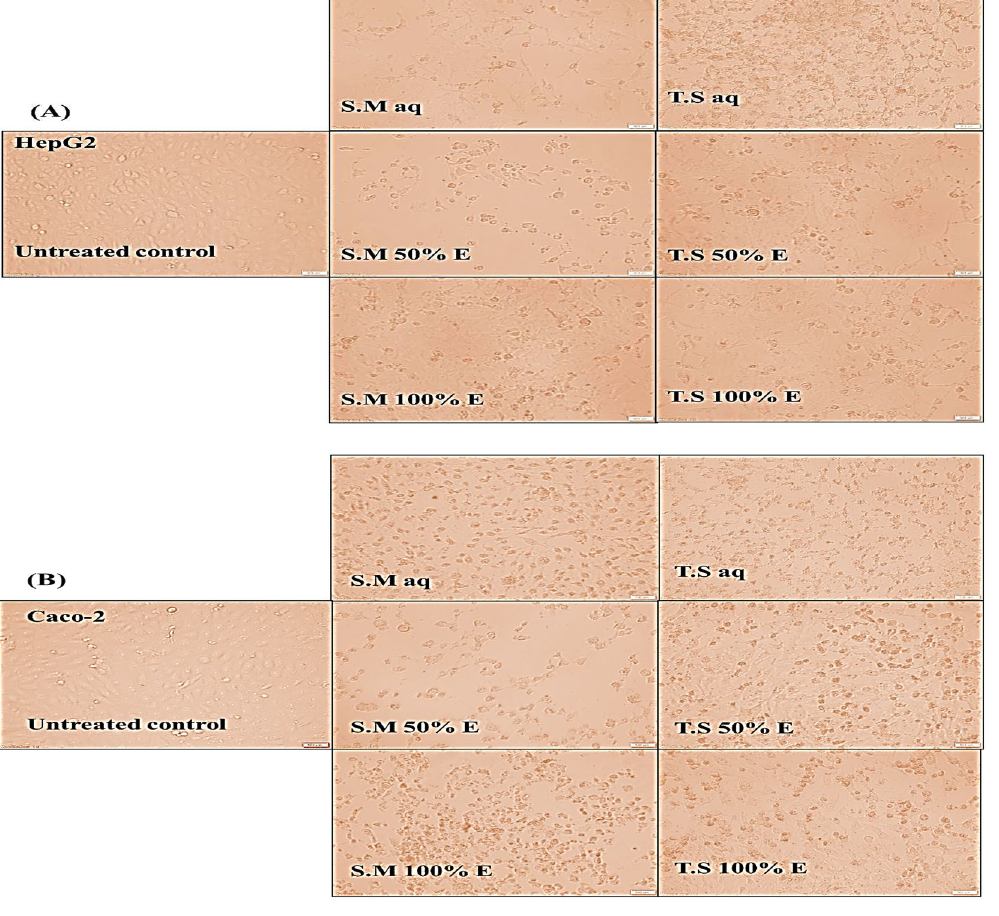
Figure 4. MTT results of growth inhibitory effect. Cytotoxicity effect as it was demonstrated by ( A ) Morphological alteration of different aqueous, 100% EE and 50% EE Salix mucronata and Tritticum spelta plant extracts treated HepG2 cancer cell line. ( B ) Morphological alteration of different aqueous, 100% EE and 50% EE Salix mucronata and Tritticum spelta plant extracts treated Caco-2 cancer cell